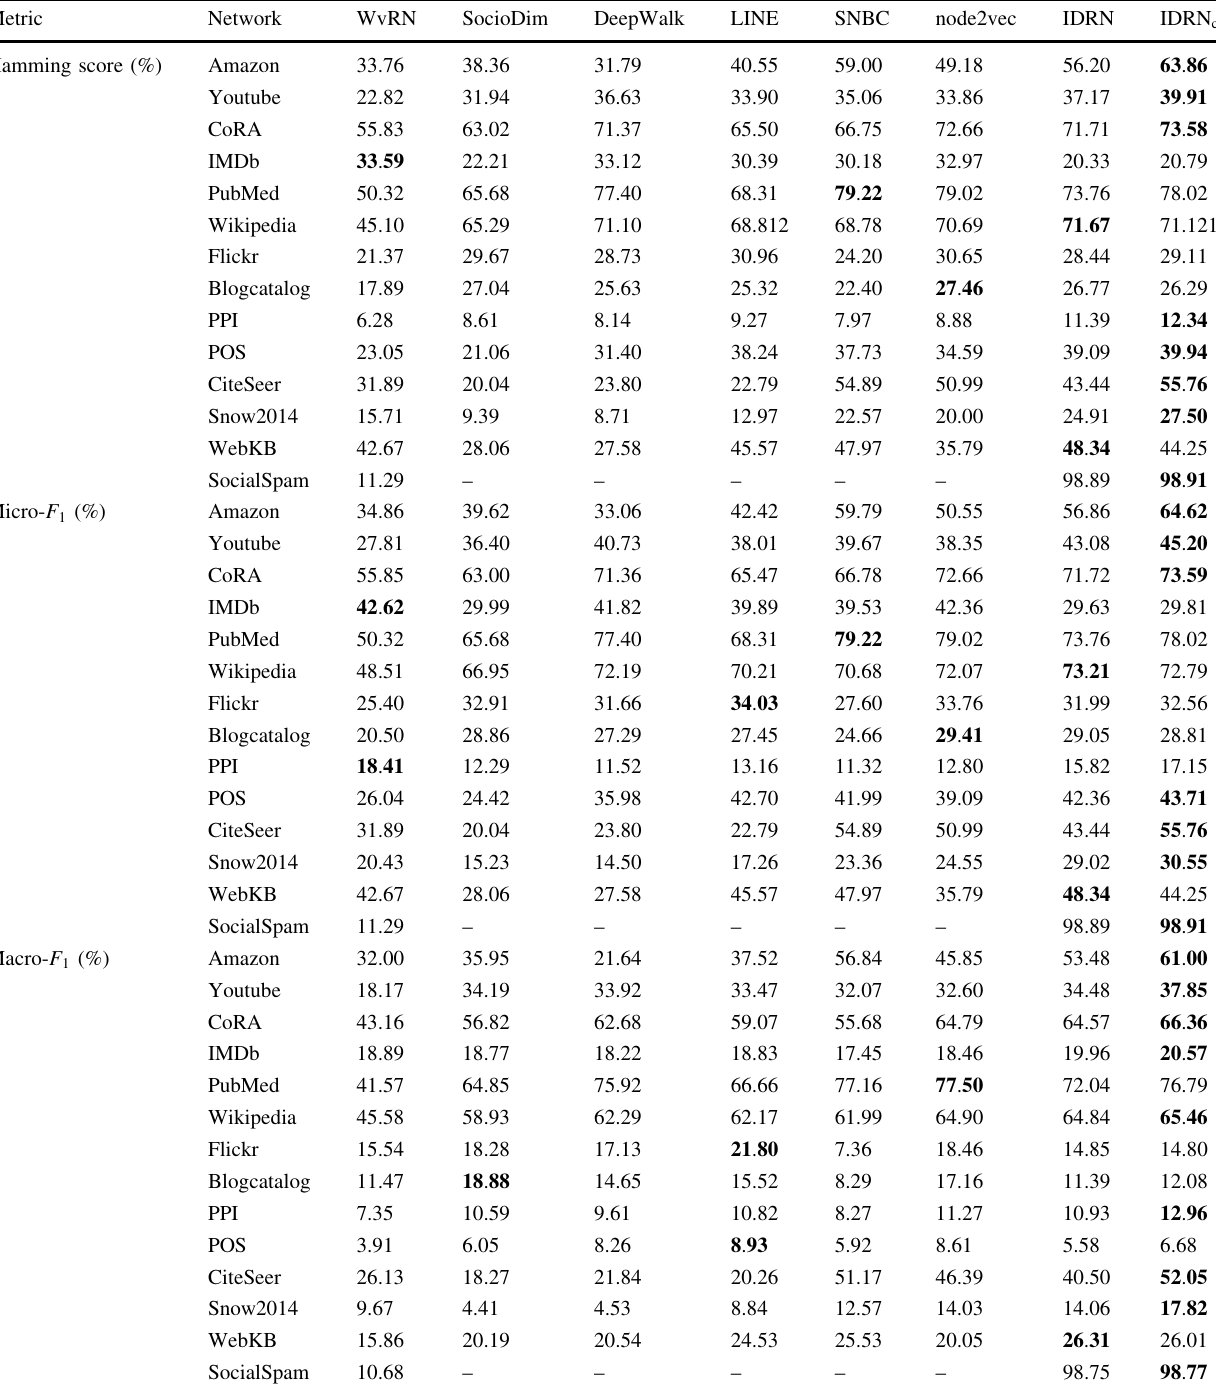
Table 4 Experiment comparisons of baselines, IDRN and IDRN c by the metrics of Hamming score, Micro (cid:4) F 1 score and Macro (cid:4) F 1 score with 10% labeled nodes for training Metric Network WvRN SocioDim DeepWalk Hamming score